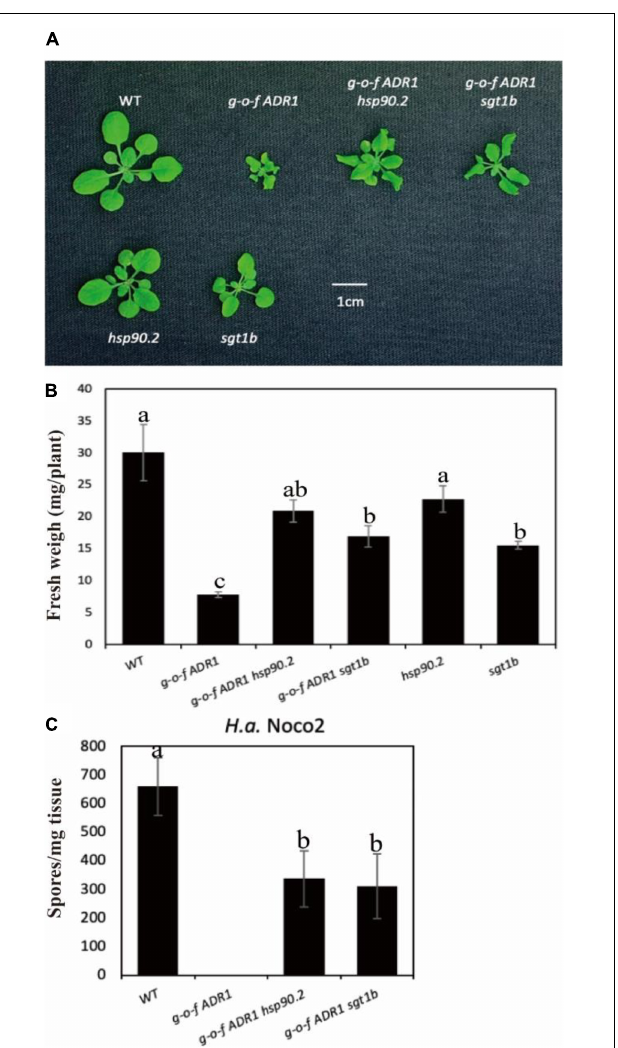
FIGURE 3 | Mutations at HSP90s or SGT1b partially suppress the autoimmunity of ADR1-L2 D484V . (A) Morphology of 3-week-old soil-grown plants of ADR1-L2 D484V hsp90, ADR1-L2 D484V sgt1b double mutant at 23 ◦ C. (B) Weights of 3-week-old soil-grown plants of ADR1-L2 D484V hsp90, ADR1-L2 D484V sgt1b double mutant at 23 ◦ C. (C) Quantification of H.a. Noco2 conidia growth on leaf surface of ADR1-L2 D484V hsp90, ADR1-L2 D484V sgt1b double mutant. The experiment was carried out as described in Figure 1 . One-way ANOVA followed by Tukey’s post hoc test were performed for panels (B,C) . Statistical significance is indicated by different letters ( P < 0.05). Error bars represent mean SD ( n =